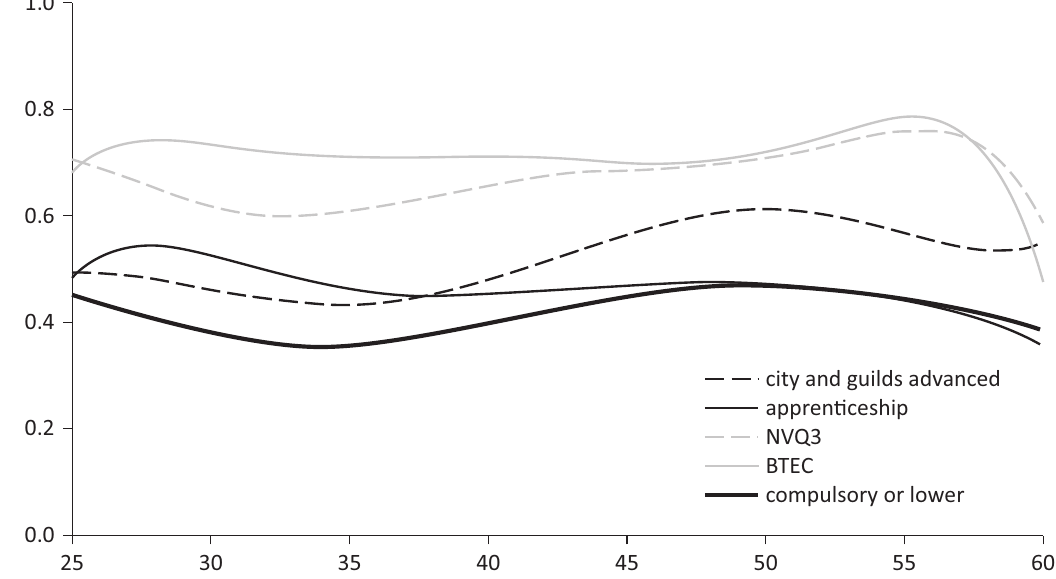
Figure A8. Median annual work income by type of upper-secondary vocational education. Women—United Kingdom. Source: UK Labour Force Survey 1993–2014. Note: 1 = Median annual income for UK